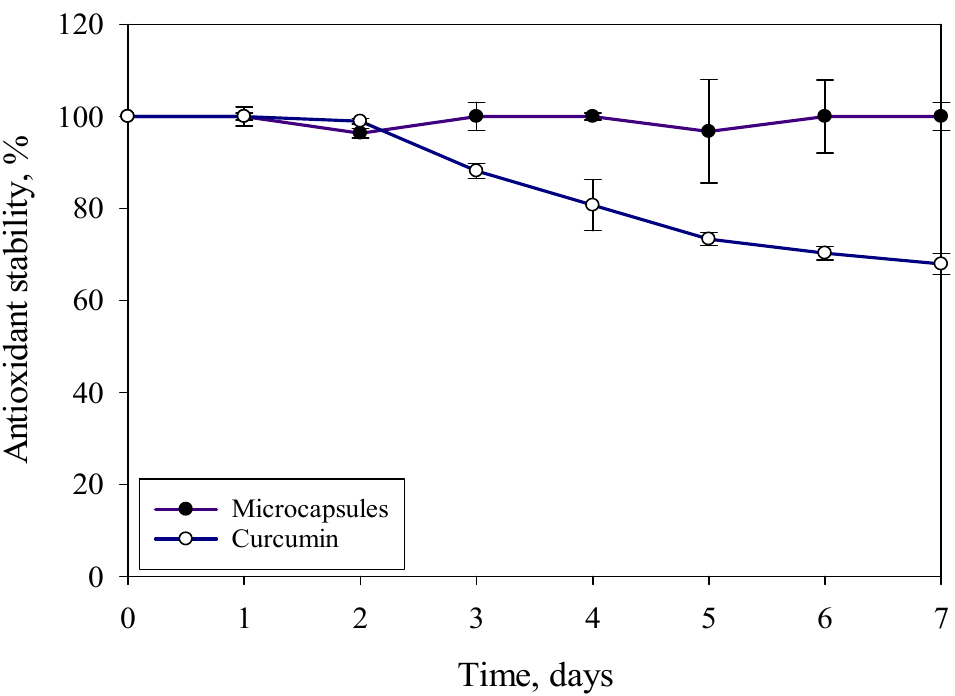
Figure 7. Antioxidant stability of curcumin and microcapsules after being stored in a desiccator for 6 months and antioxidant stability for 7 days in the room temperature.